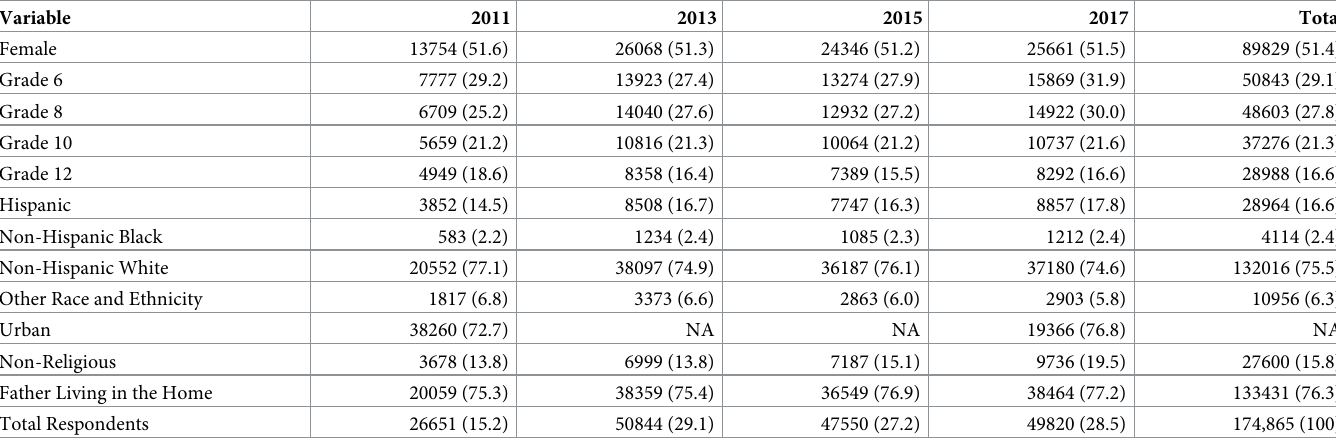
Table 1. Demographic information for each survey